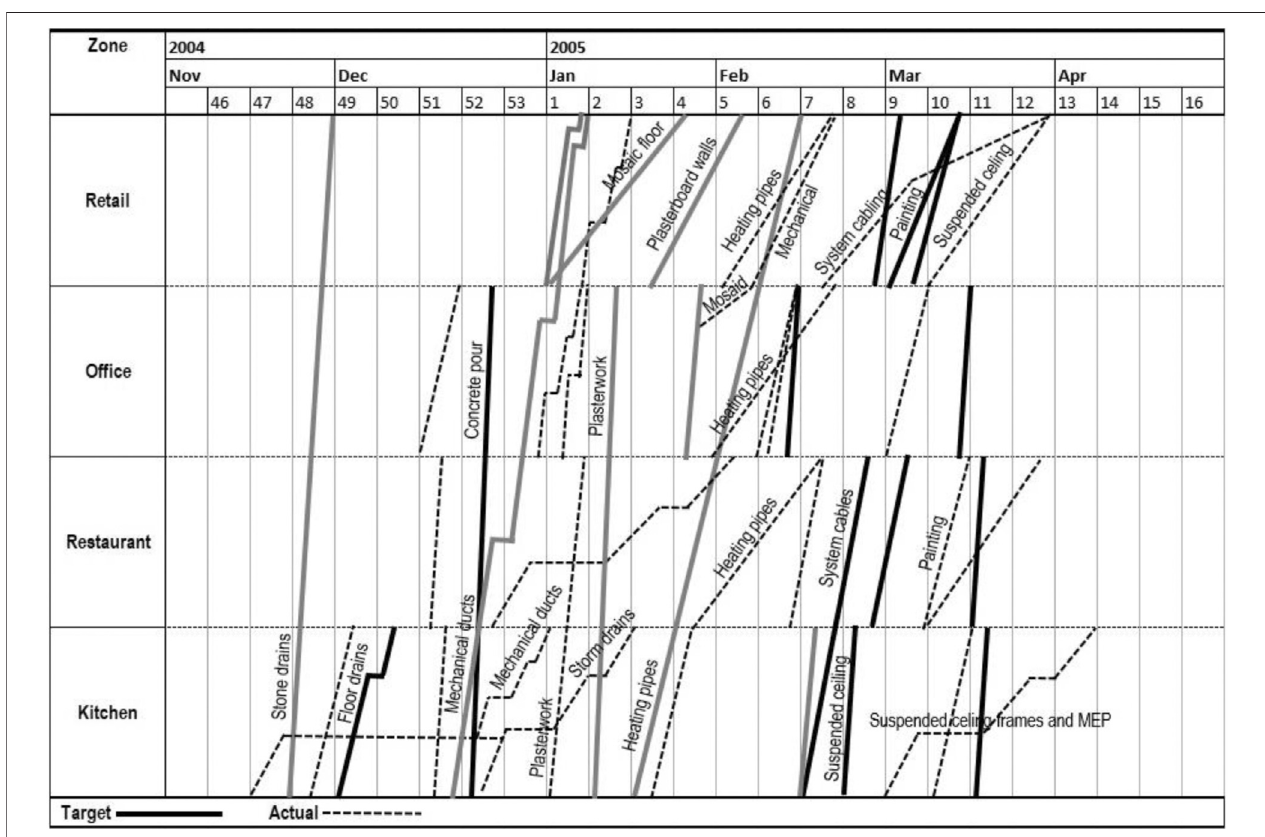
FIGURE7| LOB makes visibleactivity con fl ictswhichiscrucialwhenmakingdecisions about where and when toprioritize applicationofautomationand robotics. Adapted from Kenley and Seppanen (2010), Fig 17.10, p. 534.